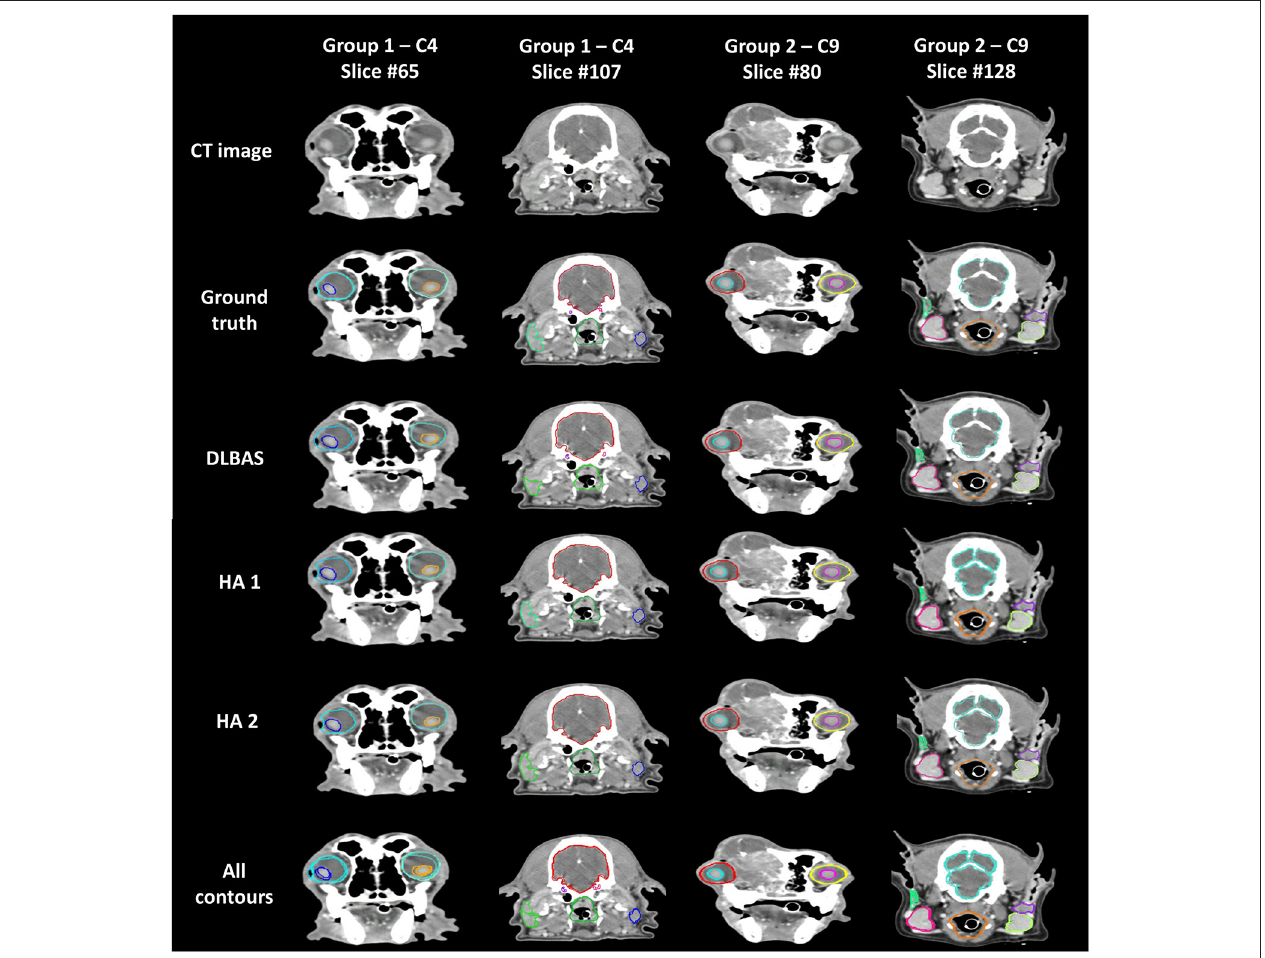
FIGURE 5 | Examples of ground truth deep-learning-based automatic segmentation, and human annotations used in clinical test sets in groups 1 and 2. All contours of the three methods are combined and displayed on each slice. Slice #65 shows the eye (aqua, aquamarine), and lens (blue, orange). Slice #107 shows the brain (red), cochlear (purple, pink), parotid salivary gland (lime, blue), and pharynx and larynx (green). Slice #80 shows the eye (red, yellow), and lens (aqua, pink). Slice #128 shows the brain (aquamarine), mandibular salivary gland (red, yellow-green), parotid salivary gland (green, purple), and pharynx and larynx (orange). CT, computed tomography; DLBAS, deep learning-based automatic segmentation; HA, human